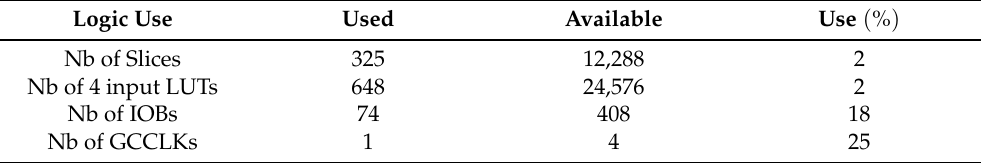
Table 2. Hardware resource utilization of the design (RAM with CORE Generator).